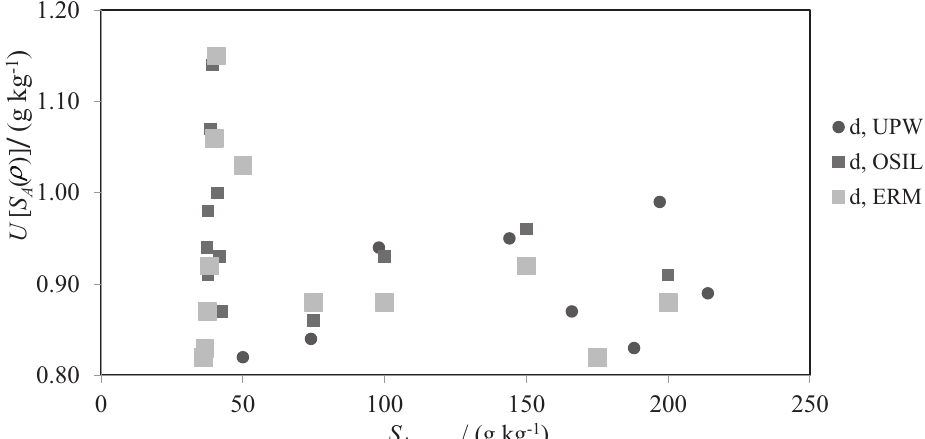
Fig. 4. Expanded uncertainty, U ( S A ( r )), of the absolute salinity values, S A obtained from the measured values of density, r , at 20 ° C, for NaCl in ultrapure water (UPW), in OSIL SSW and in ERM SSW solutions.